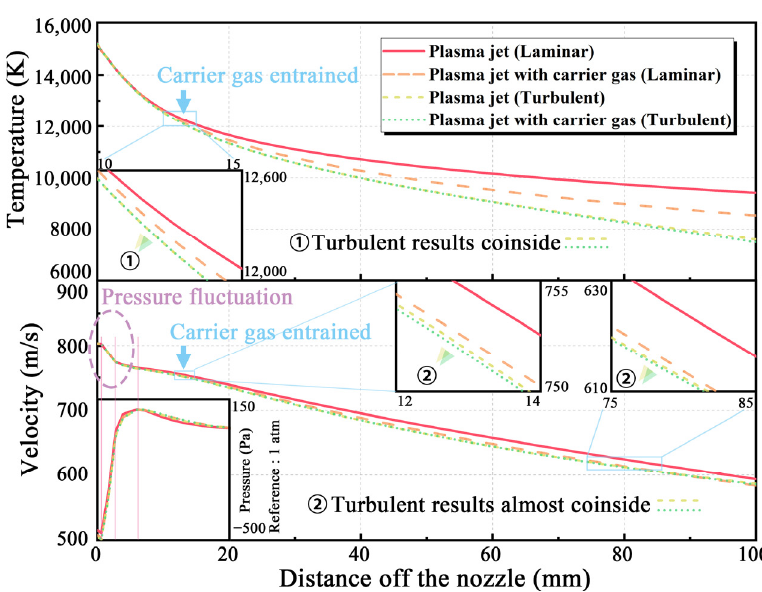
Figure 8. Calculated temperature and velocity distributions of plasma jet along the central axis.